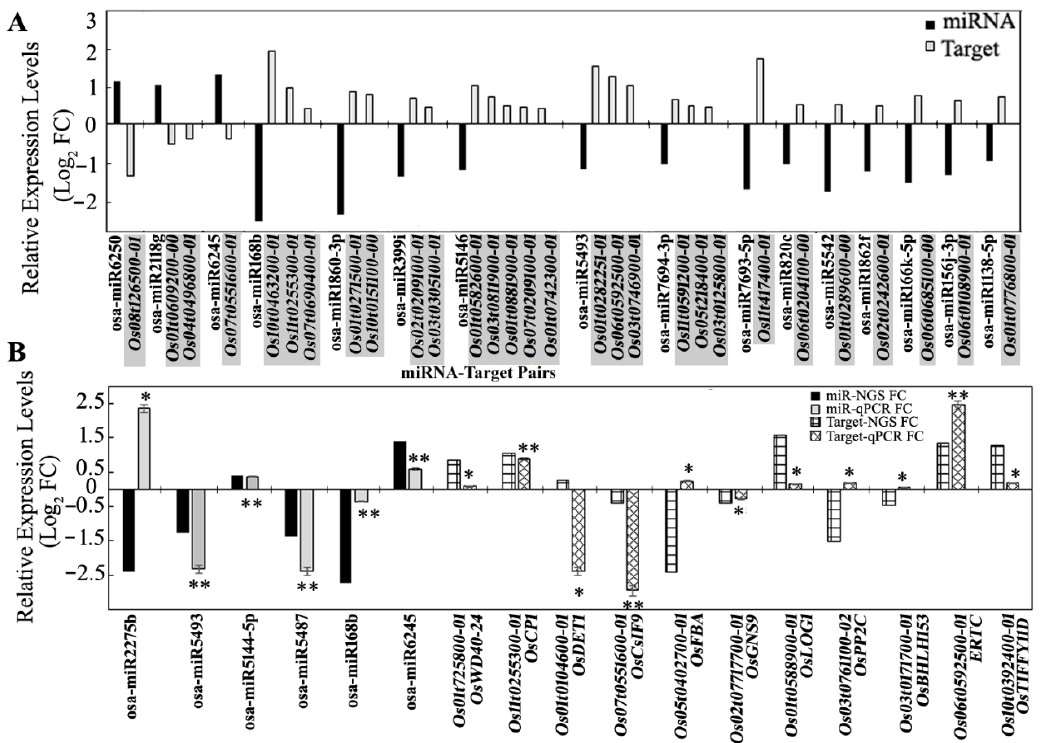
Figure 5. Relative expression levels of DEms and their respective targets. ( A ) Relative expression of top 3 up- and 13 downregulated DEms were obtained from miRNA sequencing. Corresponding cleaved targets were identified with degradome sequencing data. Transcription expression of these targets were filtered from microarray expression data. All data were verified with two replicates for each miRNA or transcript. ( B ) Concordance of relative expression levels of 6 miRs from NGS and 11 targets from microarray were verified using qRT-PCR. Fold change (FC) in gene expression was calculated using the 2 −ΔΔ Ct method. The relative transcript levels are shown as Log 2 FC. Each data point is a mean of 2 biological replicates performed in triplicate, and the error bar represents the standard error of the mean. * and ** represent significance at p ≤ 0.5 and p ≤ 0.01, respectively.